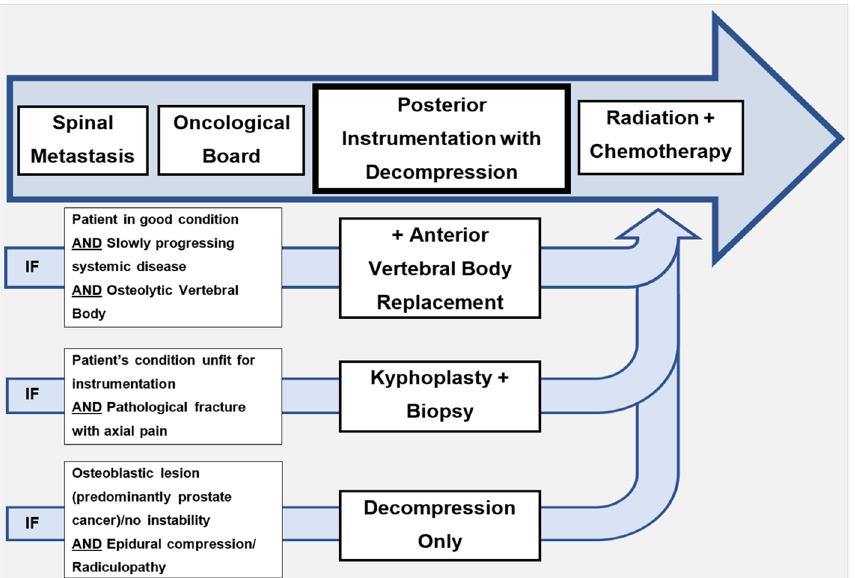
Figure 4. Algorithm for surgical management of patients diagnosed with a SM. Statistical analysis software: IBM SPSS Statistics for Windows v. Version 25.0 (Armonk, NY, 2017). https:// www. ibm. com/ produ cts/ spss- stati